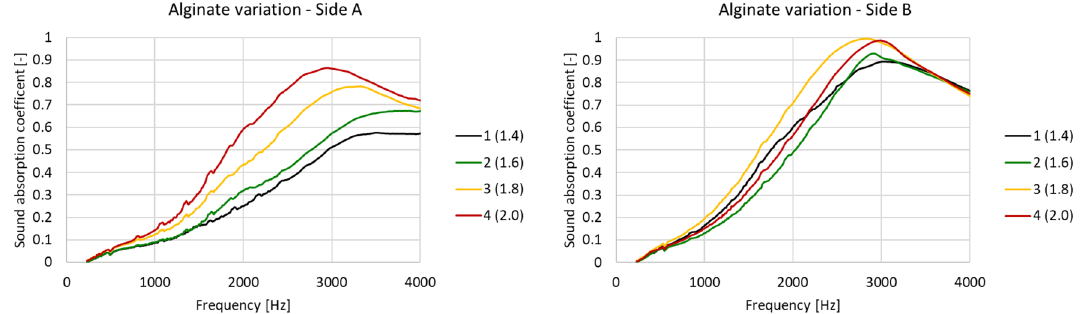
Figure 8. Sound absorption coefficient frequency variation at increasing alginate concentrations.